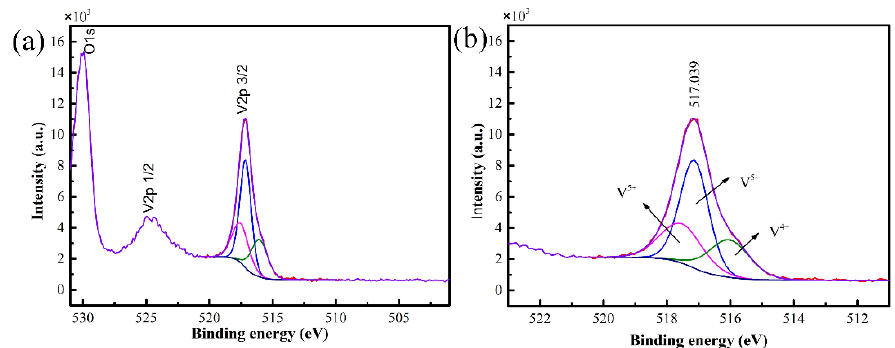
Figure 2. XPS spectra of the V 2 O 5 film ( a ) and curve fitting of V2p 3/2 spectra ( b ).